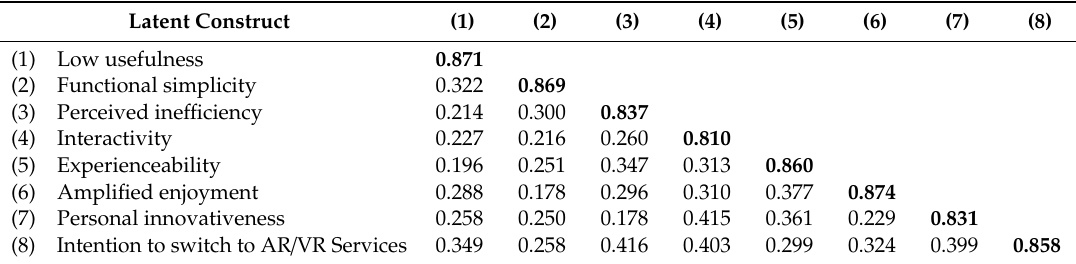
Table 5. Discriminant validity